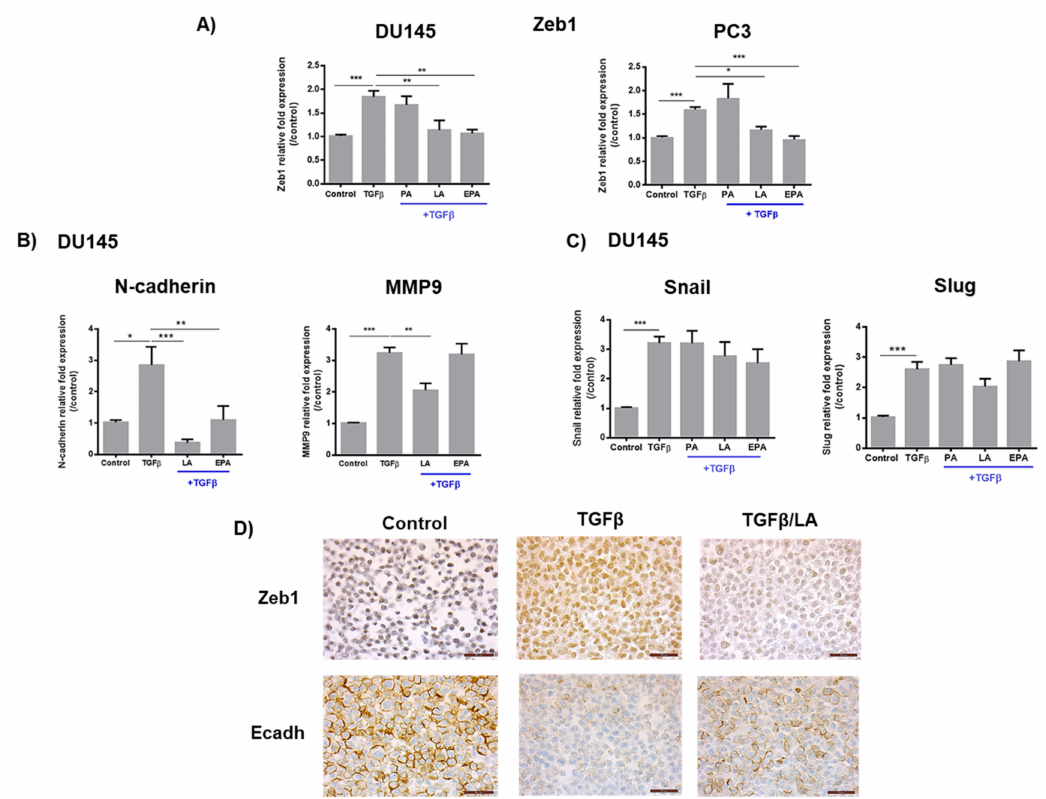
Figure 2. LA and EPA inhibit the TGF β -induced Zeb1 and its target genes expression. ( A – C ) Zeb1, N-cadherin, MMP9, Snail, and Slug mRNA levels in the prostate cancer (PCa) cell line. Cells were treated for 48 h by TGF β (10 ng / mL) ± FA (LA, EPA, AP) (20 µ M). qPCR results (mean ± SEM) are expressed in 2 - ∆∆ Ct . ( N = 3; n = 3). Statistical di ff erences are indicated: * p < 0.05; ** p < 0.01; *** p <